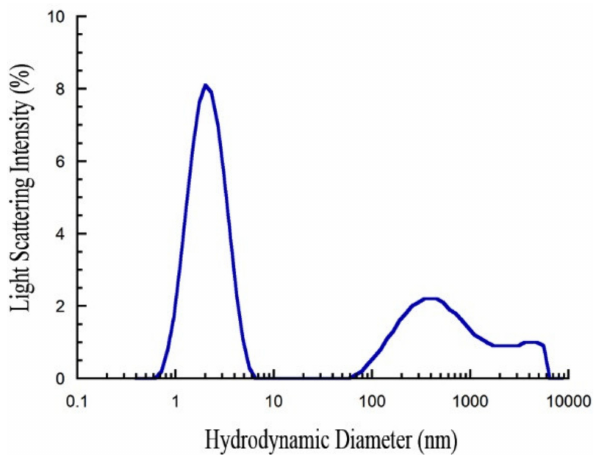
Figure 1. Size distribution of PrP 107–120 . Size distribution by light scattering intensity obtained with dynamic light scattering (DLS) for PrP 107–120 dissolved in plain water at 25 ◦ C. Peptide concentration was 1 mg / mL. The large aggregates at 70–7000 nm are quantitatively irrelevant, as light scattering intensity scales with the sixth power of the